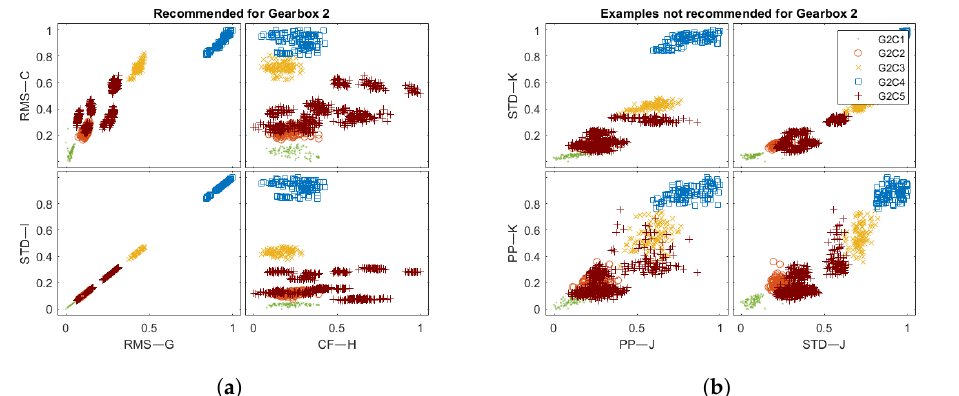
Figure 13. The feature space obtained for Gearbox 2 test set for: ( a ) recommended and ( b ) not recommended processing